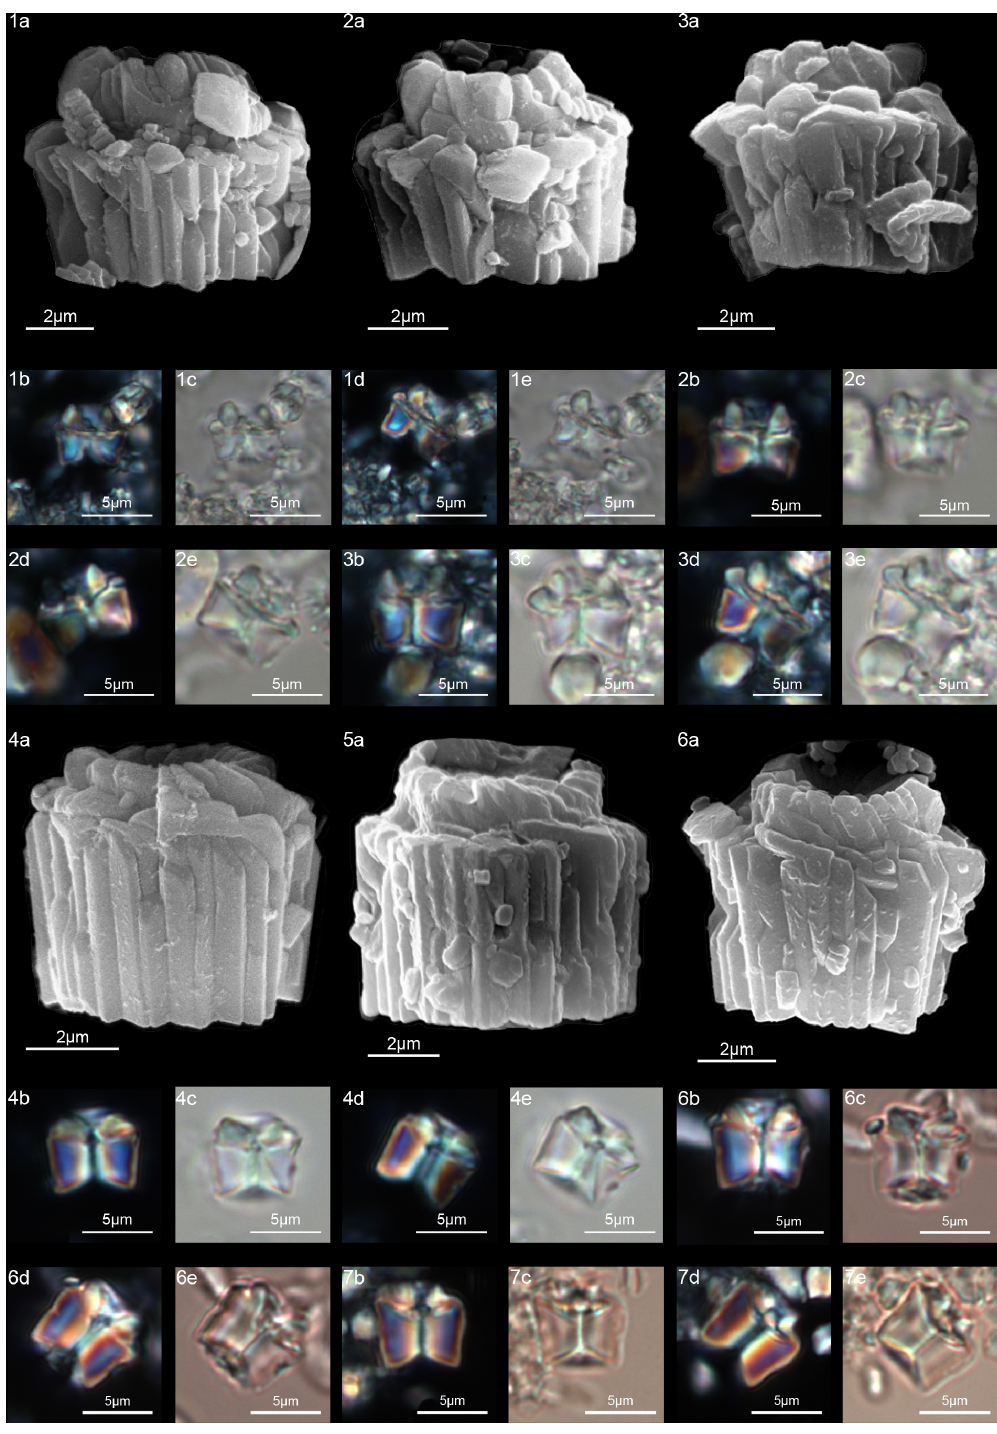
Figure 18. Lithoptychius maioranoae . (1) Paratype (IGF 104725). Sample: 1209C 14-1, 56–57. (1a) SEM, (1b, d) XPL, (1c, e) PPL. (2) Holotype (IGF 104724). Sample: 1209C 14-1, 56–57. (2a) SEM, (2b, d) XPL, (2c, e) PPL. (3) Sample: 1209C-14-1, 56–57. (3a) SEM, (3b, d) XPL, (3c, e) PPL. Lithoptychius ulii . (4) Sample: 1209C 14-1, 56–57. (4a) SEM, (4b, d) XPL, (4c, e) PPL. (5) Sample: 1267A 29-1, 60–61. (5a) SEM. (6) Sample: 1209C 14-1, 56–57. (6a) SEM, (6b, d) XPL, (6c, e) PPL. (7) Sample: 119 37-4, 135–136. (7a, c) XPL, (7b, d) PPL. See Table S1 for sample